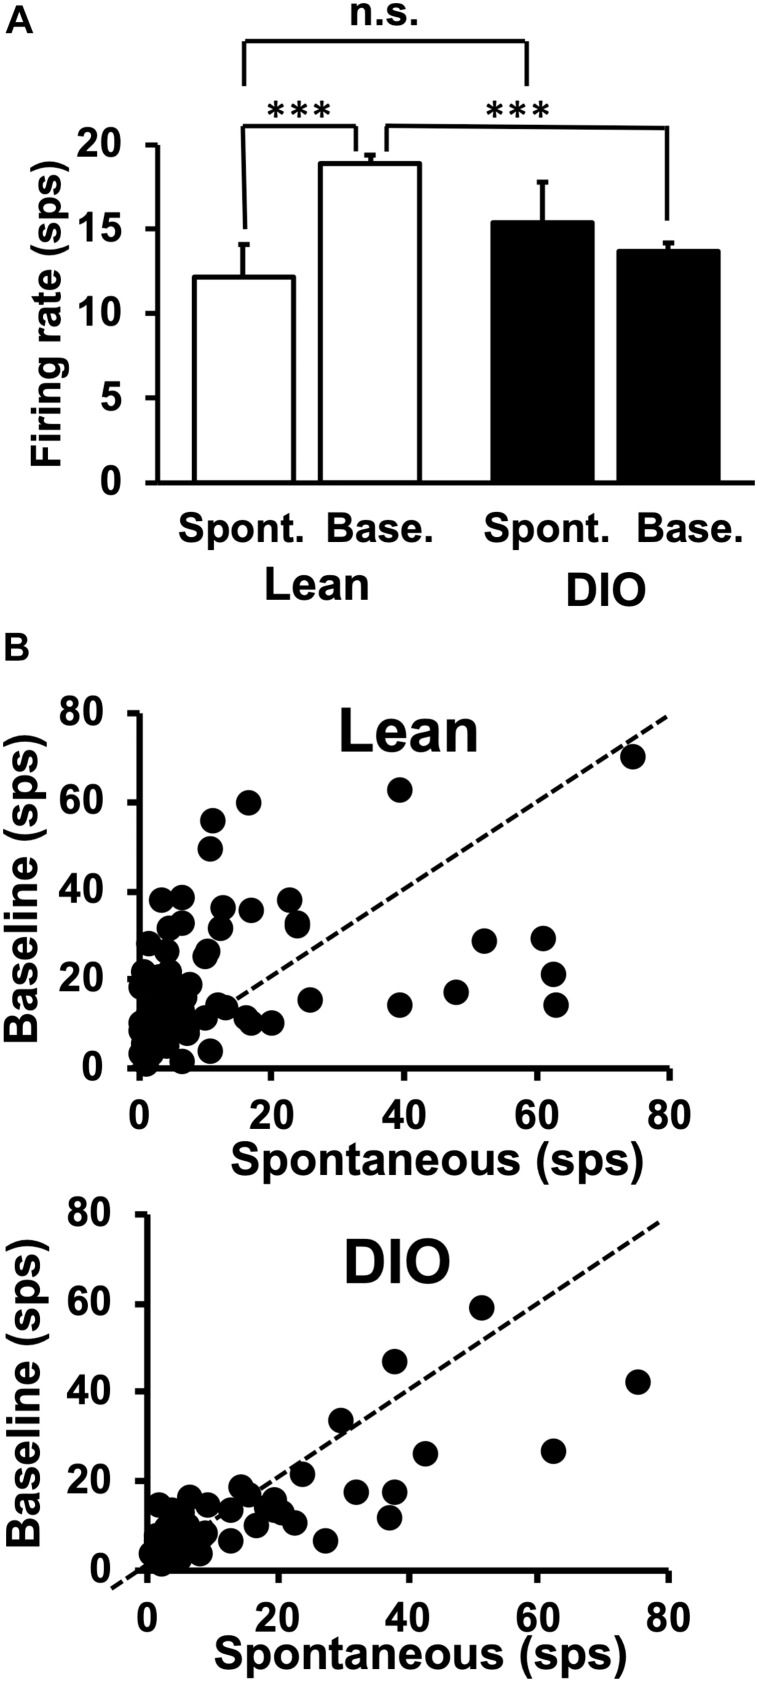
Spontaneous and baseline firing rates in NTS cells. (A) Mean firing rates are in spikes/sec ± SEM. Spontaneous firing rates are from 10 s of activity during which the animal did not lick. Baseline firing rates were calculated as the firing rate during the 1 s just prior to the first taste stimulus lick, during which period the rat was often emitting dry (unreinforced) licks. NTS cells in lean rats increase their firing rate when licking (spontaneous firing rate > baseline firing rate), but NTS cells in DIO rats do not. There was no significant difference between spontaneous rates in Lean vs. DIO rats (p = 0.29, indicated as n.s.) ∗∗∗p < 0.001. (B) Sacatterplots of spontaneous firing rate plotted against baseline firing rate for each cell in lean (top) and DIO (bottom) rats.